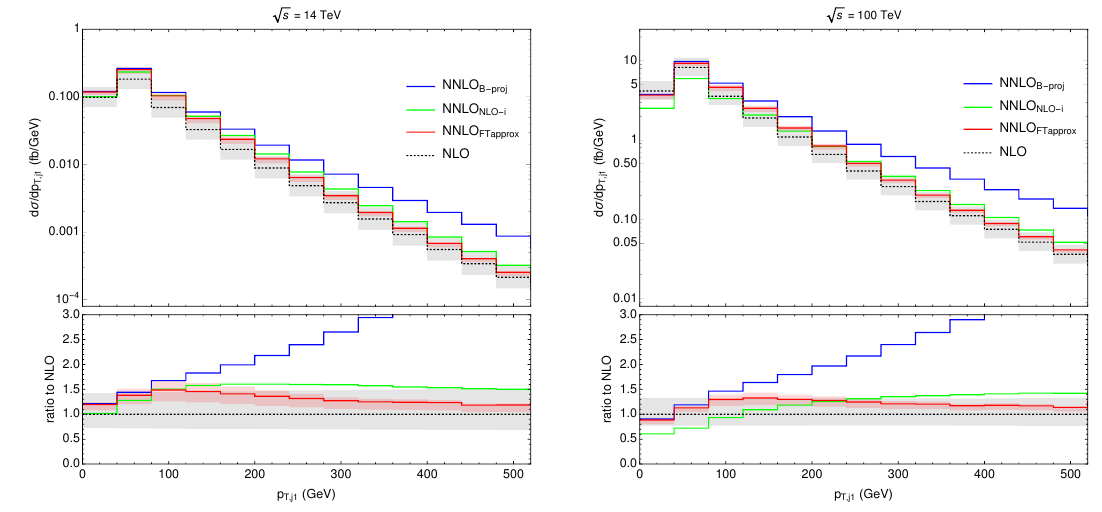
Figure 5 . Leading jet transverse momentum distributions at 14 TeV (left) and 100 TeV (right). Here jets are clustered with the anti- k T algorithm [59] with R = 0 : 4 and p T ; j1 > 30 GeV and j (cid:17) j j (cid:20) 4 :